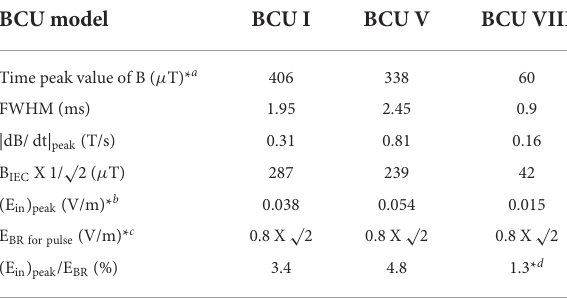
TABLE 1 Exposure assessment of the magnetic pulse emitted in magnetizing the